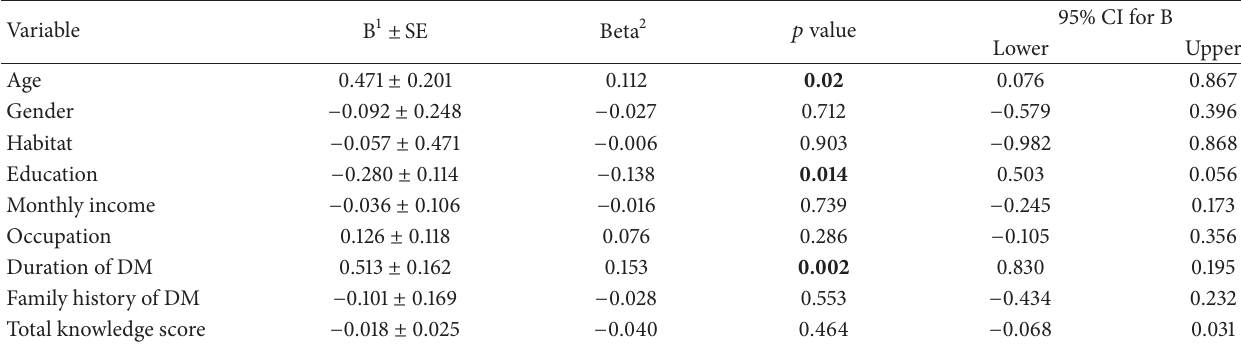
Table 4: Multivariable regression analysis of HbA 1 c level as a dependent variable with other parameters among patients with type 2 DM ( 𝑛 = 500 ).